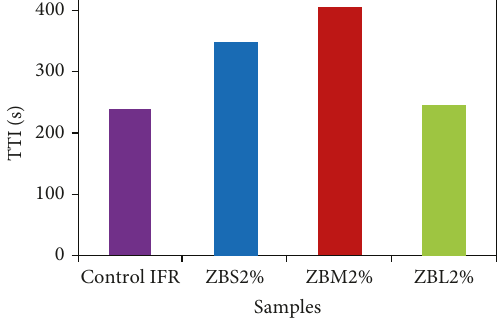
Figure 7: Ignition time of wood treated with IFR/ZB coatings (50 kw · m -2